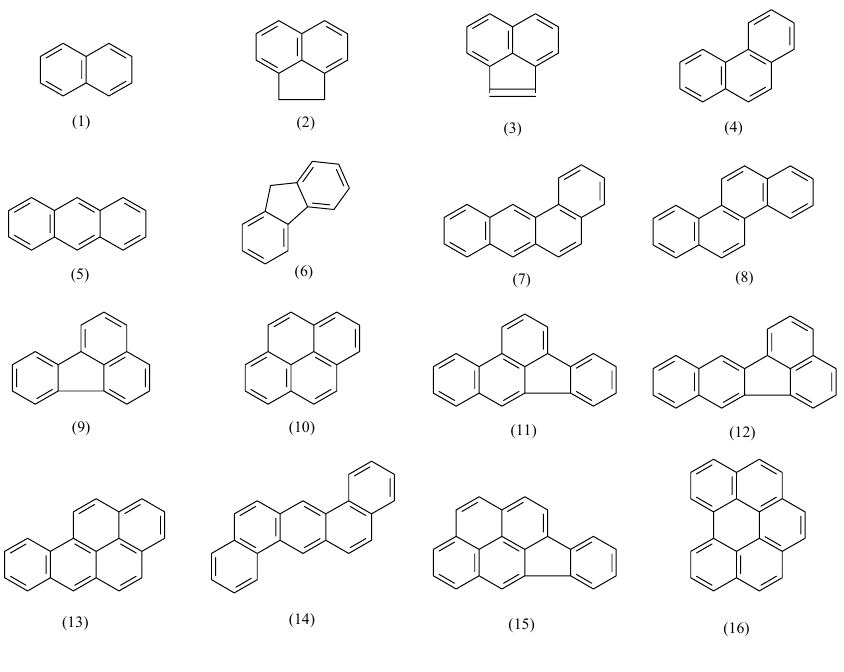
Figure 1. Molecular structures of the 16 studied